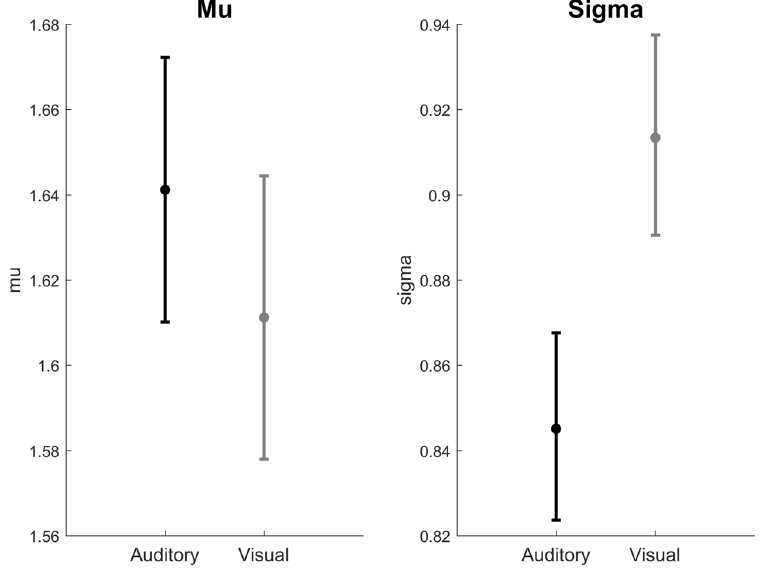
Figure 4. Mu and Sigma parameters of the log-normal distribution with 95% confidence intervals.